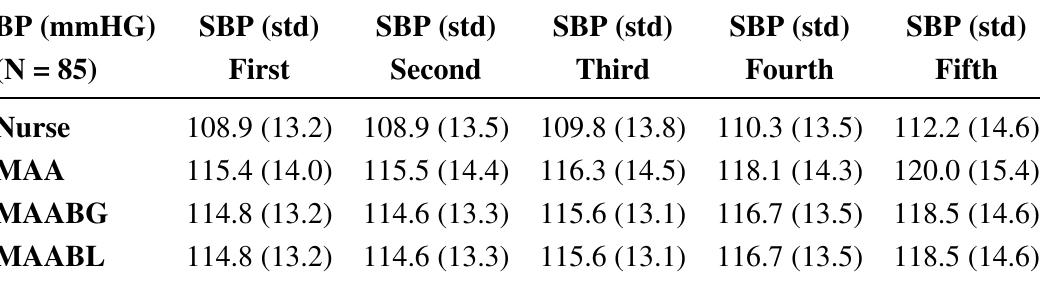
Table 3. Summary of the averaged systolic blood pressure (SBP) estimates by the nurse, the maximum amplitude algorithm (MAA), MAA using Bayesian with Gaussian (MAABG), and the maximum amplitude algorithm (MAA), MAA using Bayesian with Laplacian (MAABL); std is standard deviation; first to fifth is the sequence of measurements.